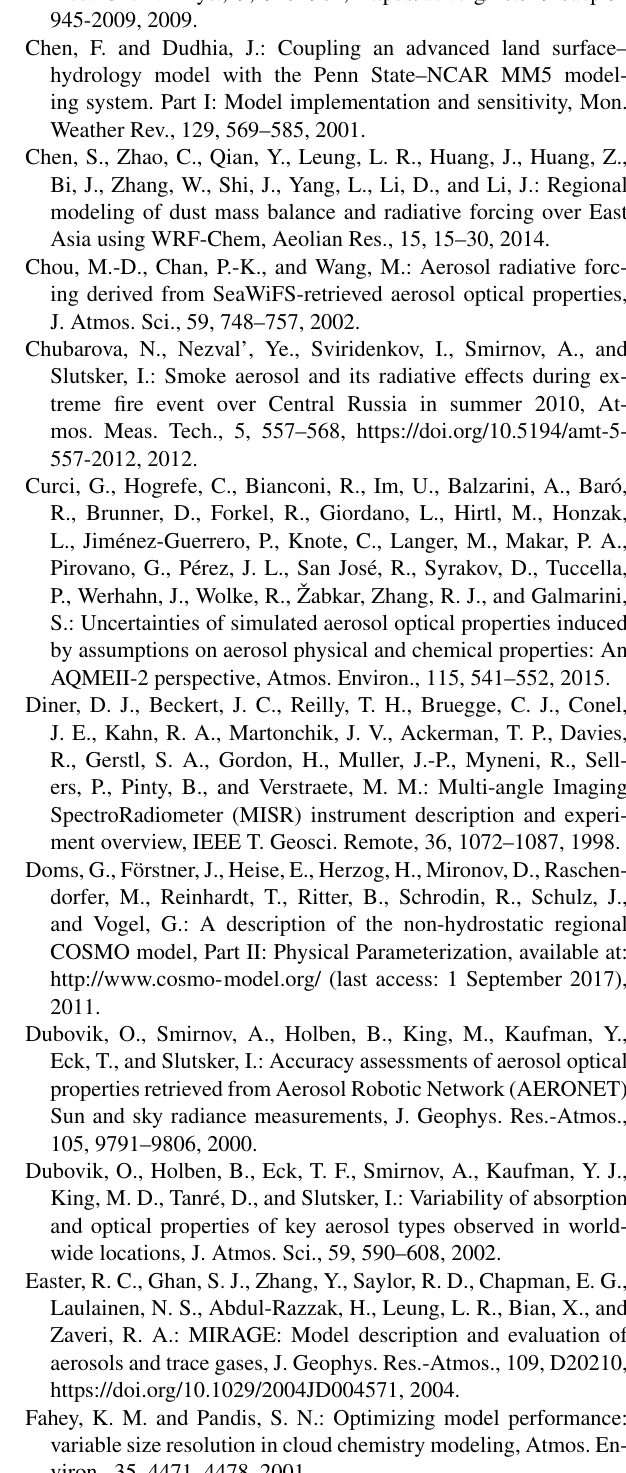
Figgans, G.: Aerosol–radiation–cloud interactions in a